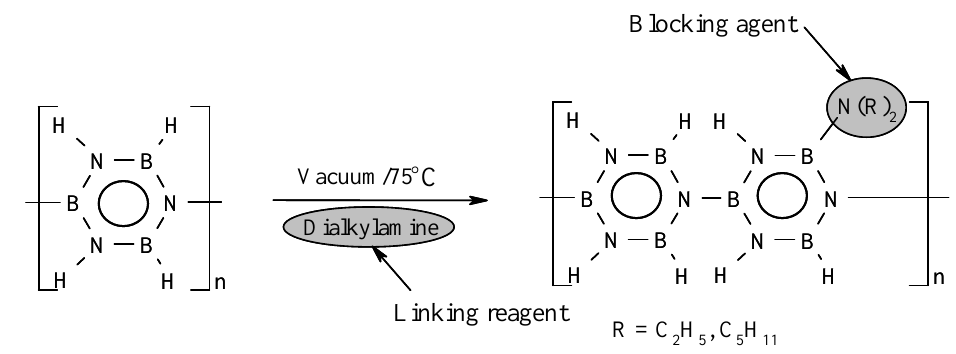
Figure 10. Amine modification of